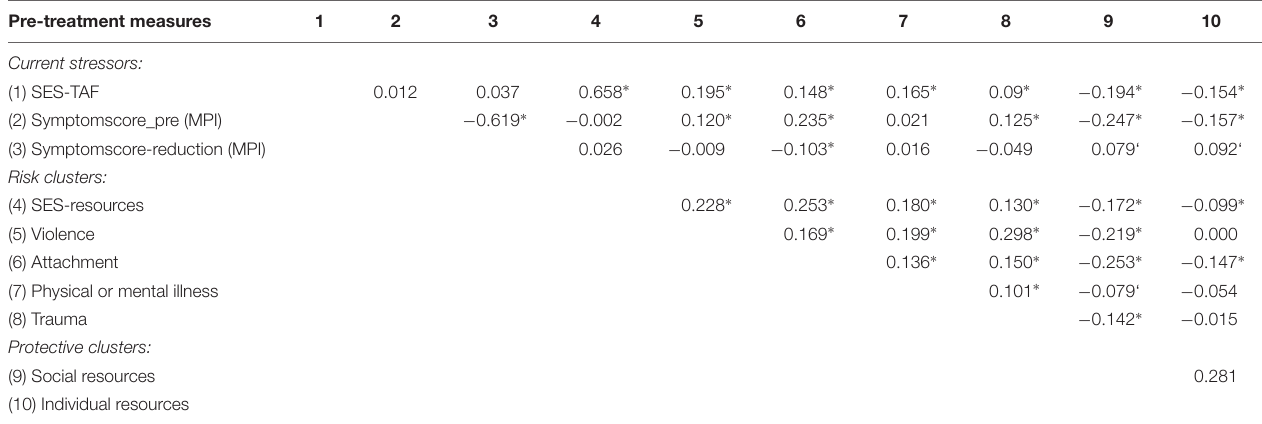
TABLE 2 | Bivariate correlation matrix of current stressors (socio-economic status and psychopathology), childhood adversities (risk-clusters), and protective clusters. Pre-treatment